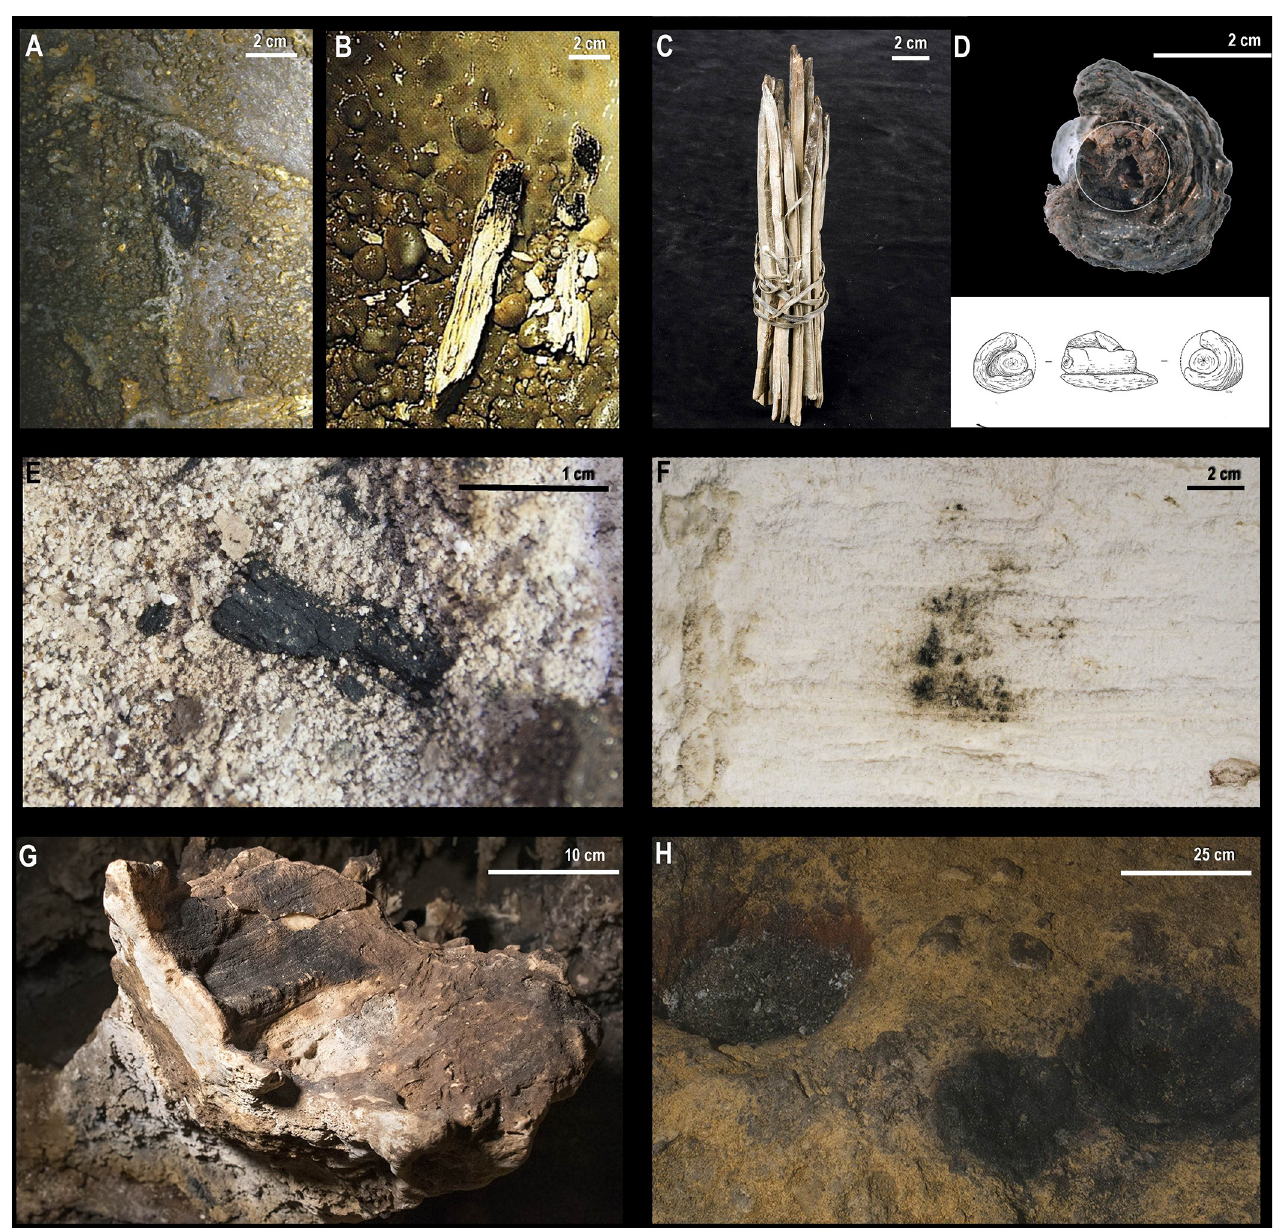
Fig 1. Prehistoric lighting remains. A. Fragments of semi-charred juniper branches covered by calcite in the cave of Ald è ne. Republished from ref. [16] under a CC BY license, with permission from Philippe Galant. B. Portion of pine wood in the Re´seau Clastres Republished from ref. [14] under a CC BY license, with permission from Jean Clottes. C. Torch preserved in the mines at Hallstatt. Published under a CC BY license, with permission from Markus Roboch, CFO in Natural History Museum Vienna. D. Side view and illustration of the Star Carr torch Published under a CC BY license in ref. [17]. E. Scarred charcoal from Nerja Cave; F. Black marks from Nerja Cave; G. Fixed lamp from Nerja Cave. H. Fireplaces in a pit in Enl è ne Cave. Published under a CC BY license, with permission from Jean Clottes].